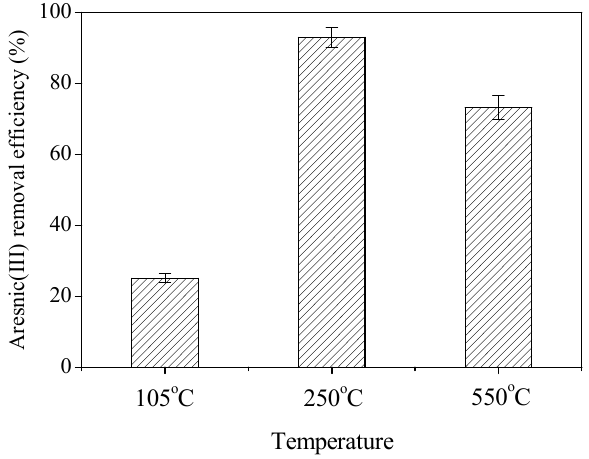
Figure 6. Arsenic(III) removal efficiency of bio-schwertmannite before and after heating.